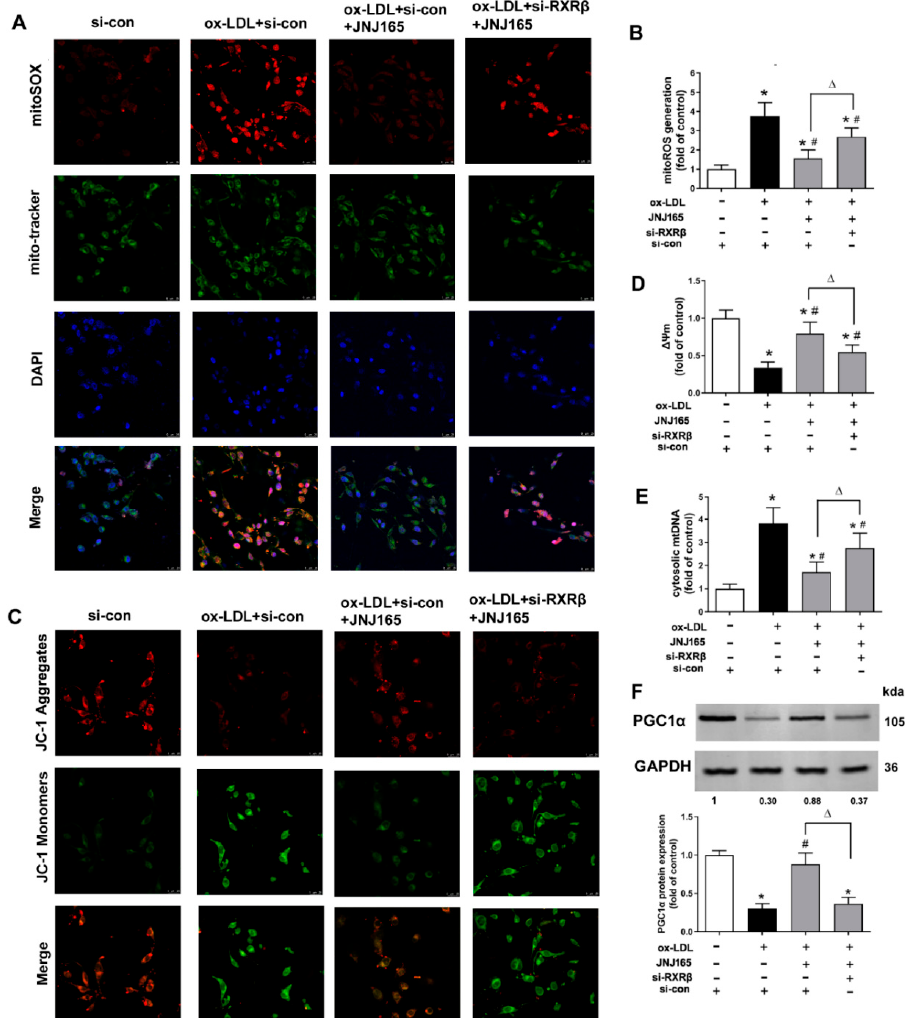
Figure 5. MDM2 inhibitor JNJ-165 provides protection against ox-LDL-induced